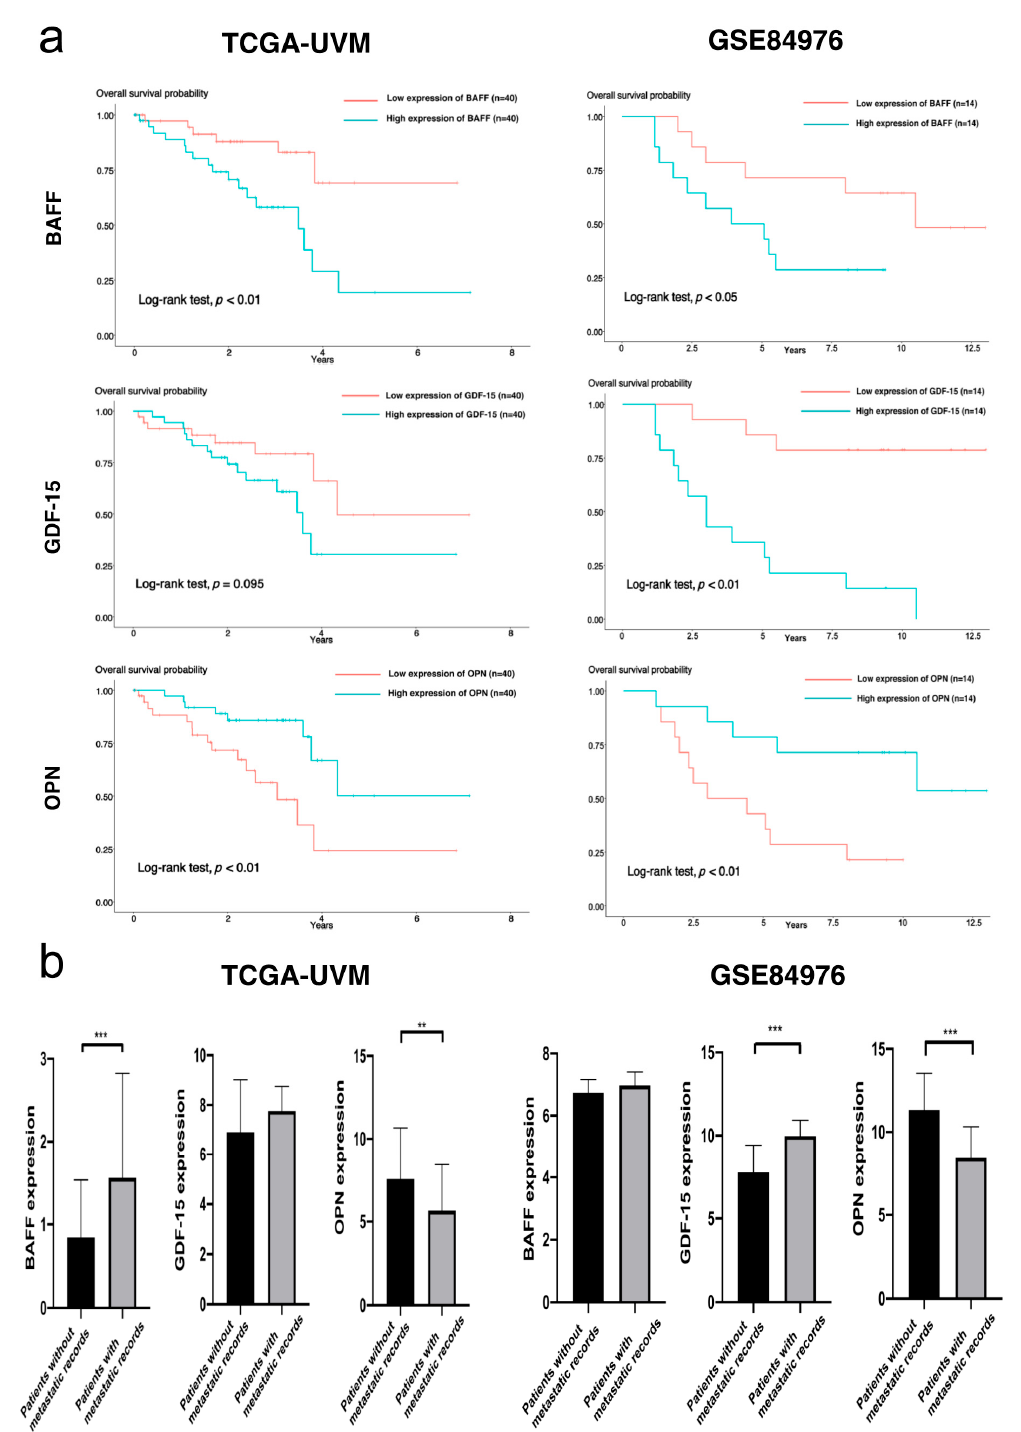
Figure 7. ( a ) Kaplan–Meier survival analysis of high and low gene expression of three markers in two external datasets (TCGA-UVM and GSE84976), log-rank tests were used to check the p -values; ( b ) Bar plots showing the gene expression of three markers in TCGA-UVM and GSE84976. In each bar plot, the Student’s t -test was conducted to compare the transcriptomic levels of three markers between patients without metastatic records and those with metastatic records. Note: *** means p < 0.01, ** means p <